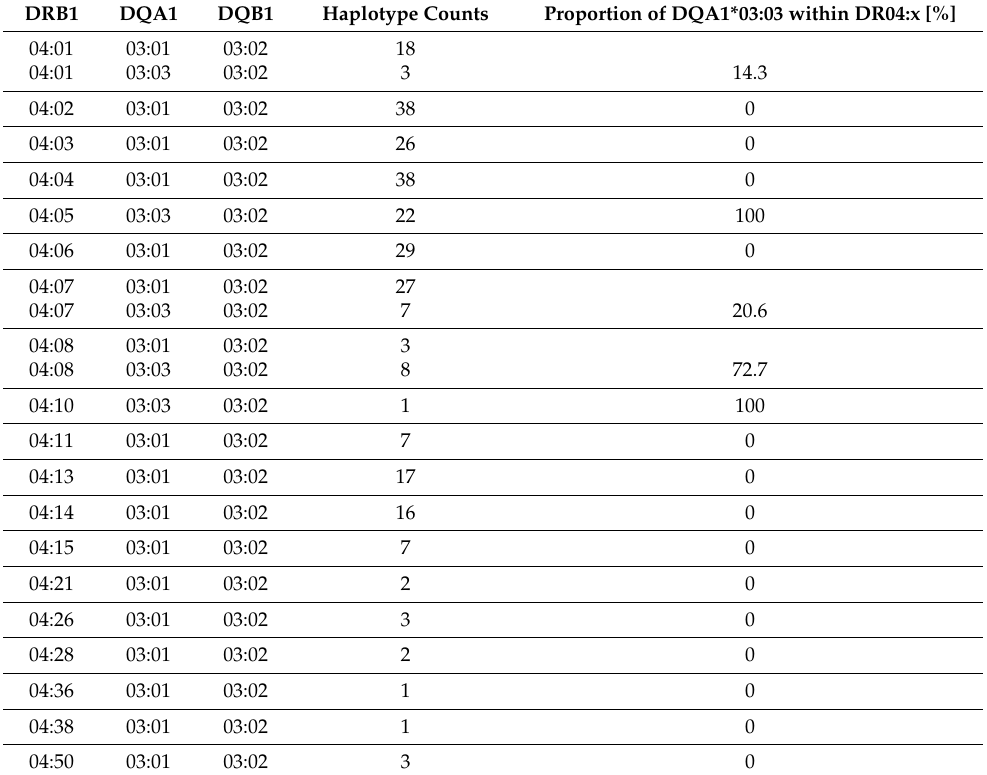
Table 2. DQA1*03:03 haplotype counts in selected DR4/DQ8 haplotypes of the general population.